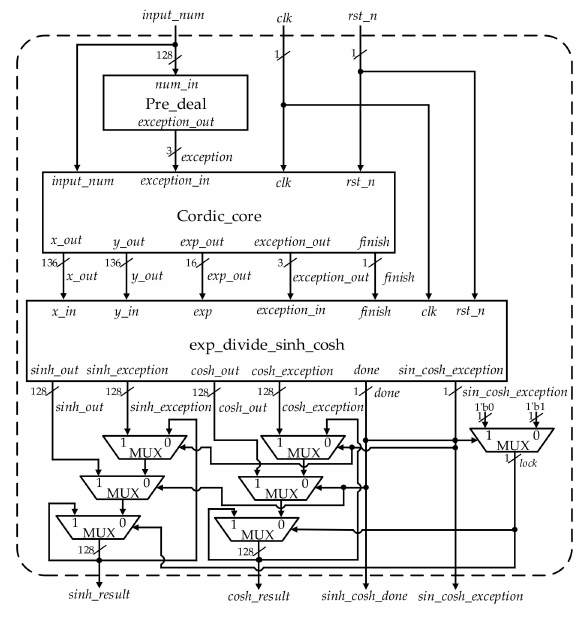
Figure 3. Overall architecture of quadruple precision functions sinh x and cosh x in FP format.